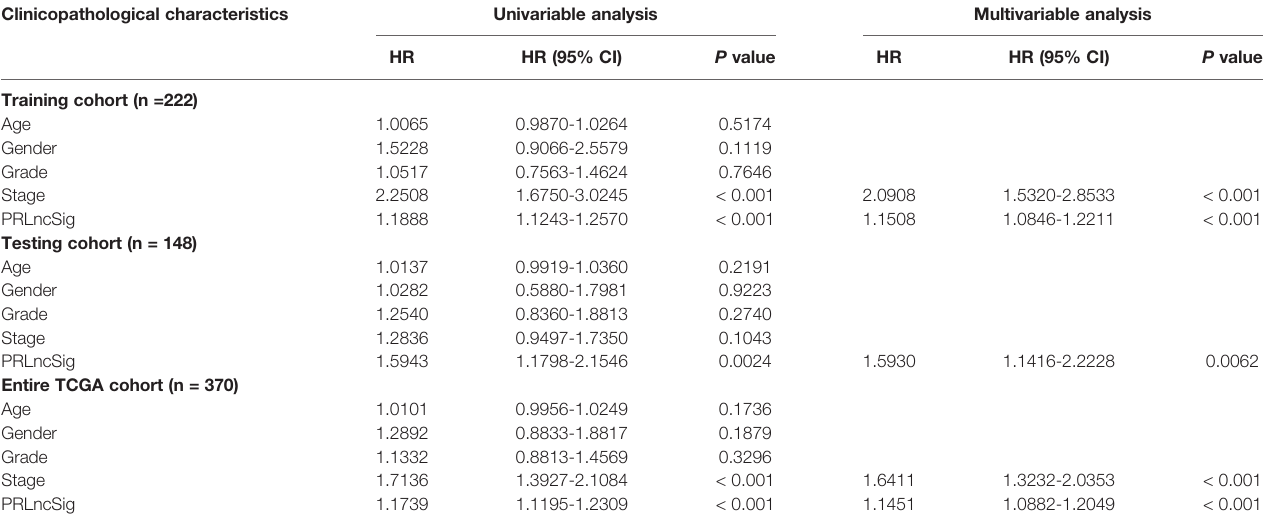
TABLE 3 | Univariate and multivariate cox regression analysis of PRLncSig and